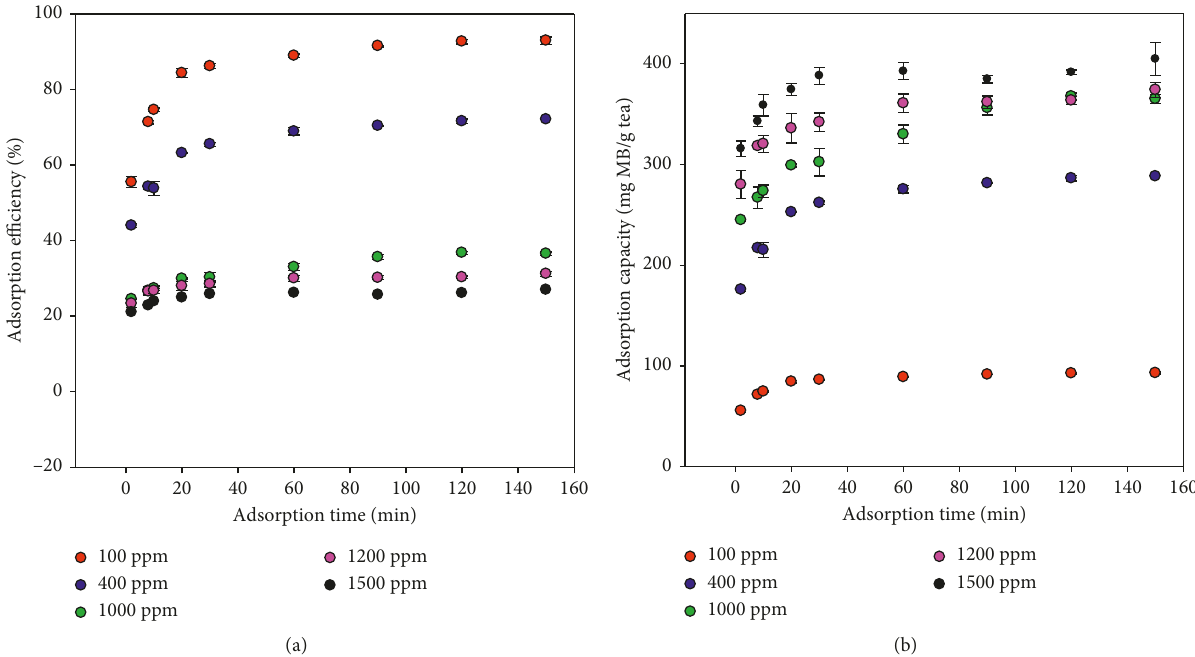
Figure 4: Effect of initial concentration on the adsorption efficiency and capacity of